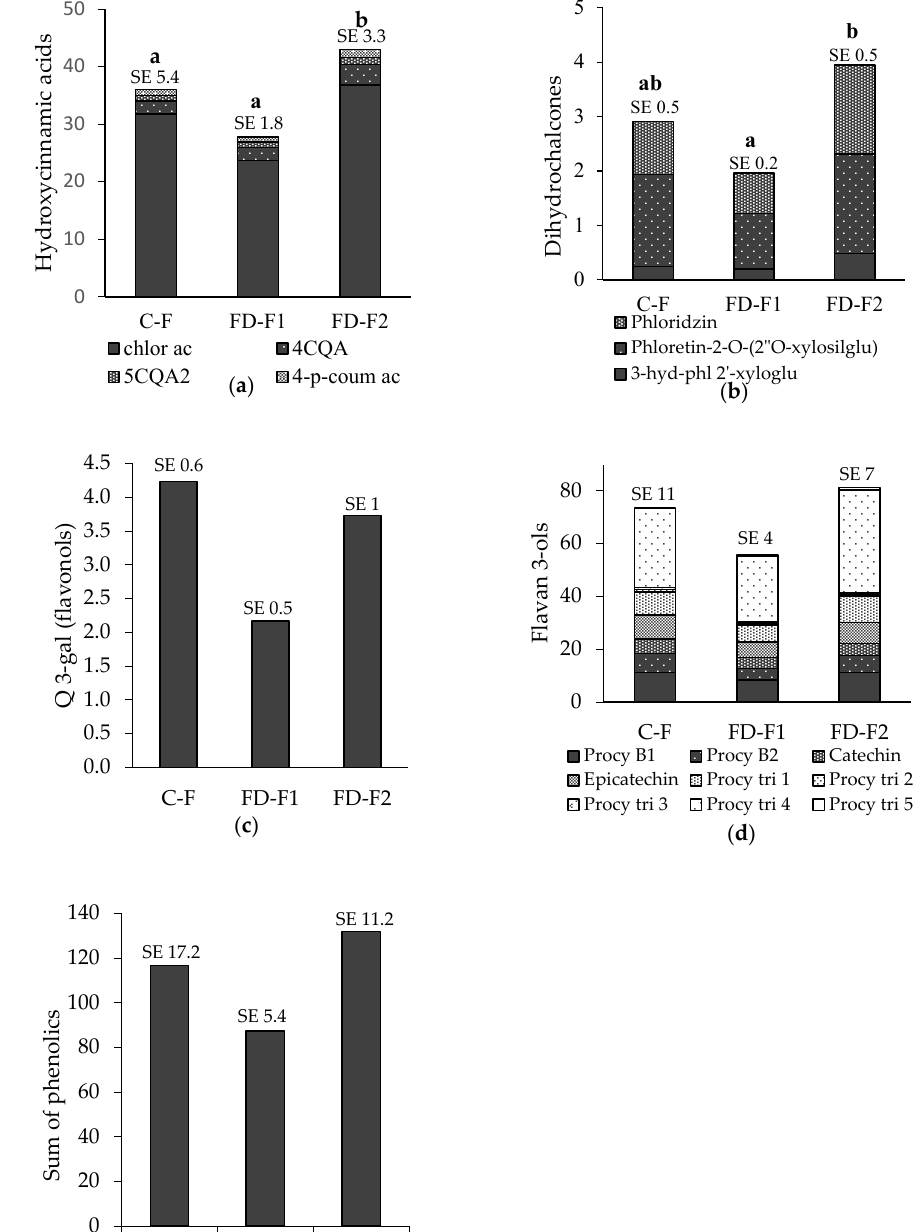
Figure 2. Content of individual phenolic compounds (mean ± SE in mg kg − 1 fresh weight), shown in groups: ( a ) hydroxycinnamic acids (chlor ac, chlorogenic acid; 4CQA, 4-caffeoylquinic acid; 5CQA2, 5-caffeoylquinic acid 2; 4-O-p-coum ac, 4-p-coumaroylquinic acid); ( b ) dihydrochalcones (3-hyd-phl 2 (cid:48) -xylglu, 3-hydroxy-phloretin-2 (cid:48) -O-xyloglucoside; phloretin-2-O-(2”O-xylosilglu, phloretin-2-O-(2”O- xyloglucoside); phloridzin); ( c ) flavonols (Q 3-gal, quercetin 3-galactoside); ( d ) flavan-3-ols (procy B1, procyanidin dimer B1; procy B2, procyanidin dimer B2; procy tri 1–5, five procyanidin trimers; catechin; epicatechin); and ( e ) sum of all phenolics in flesh of undamaged apples (C-F) and damaged apples: flesh underneath healthy peel (FD-F1) and flesh underneath corky peel (FD-F2). Different letters above columns denote statistical differences between treatments (the Duncan test. p <